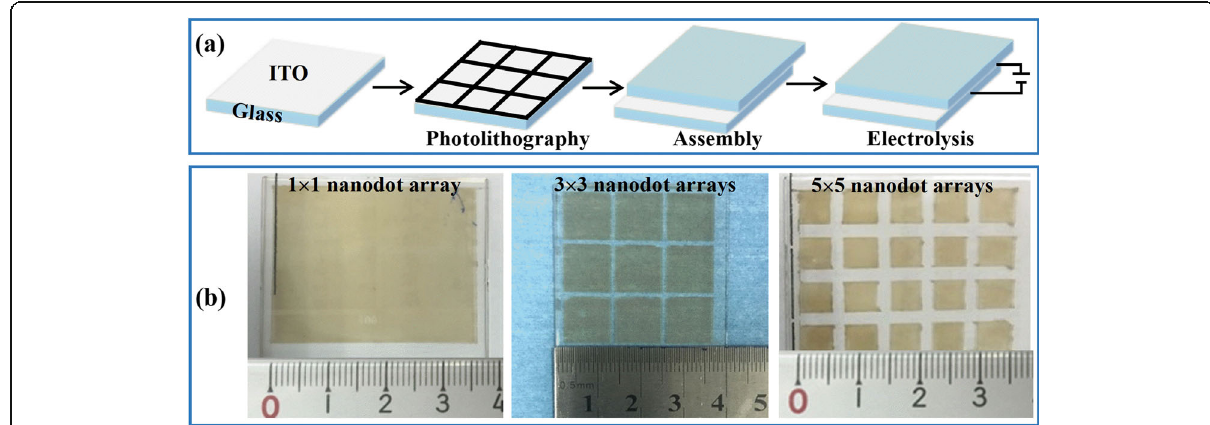
Fig. 5 a Schematic of patterning an ITO film to an array with multiple isolated areas containing NDs. b Images of the 1 × 1, 3 × 3, and 5 × 5 SERS arrays patterned from three 3.5 × 3.5 cm 2 ITO-glass